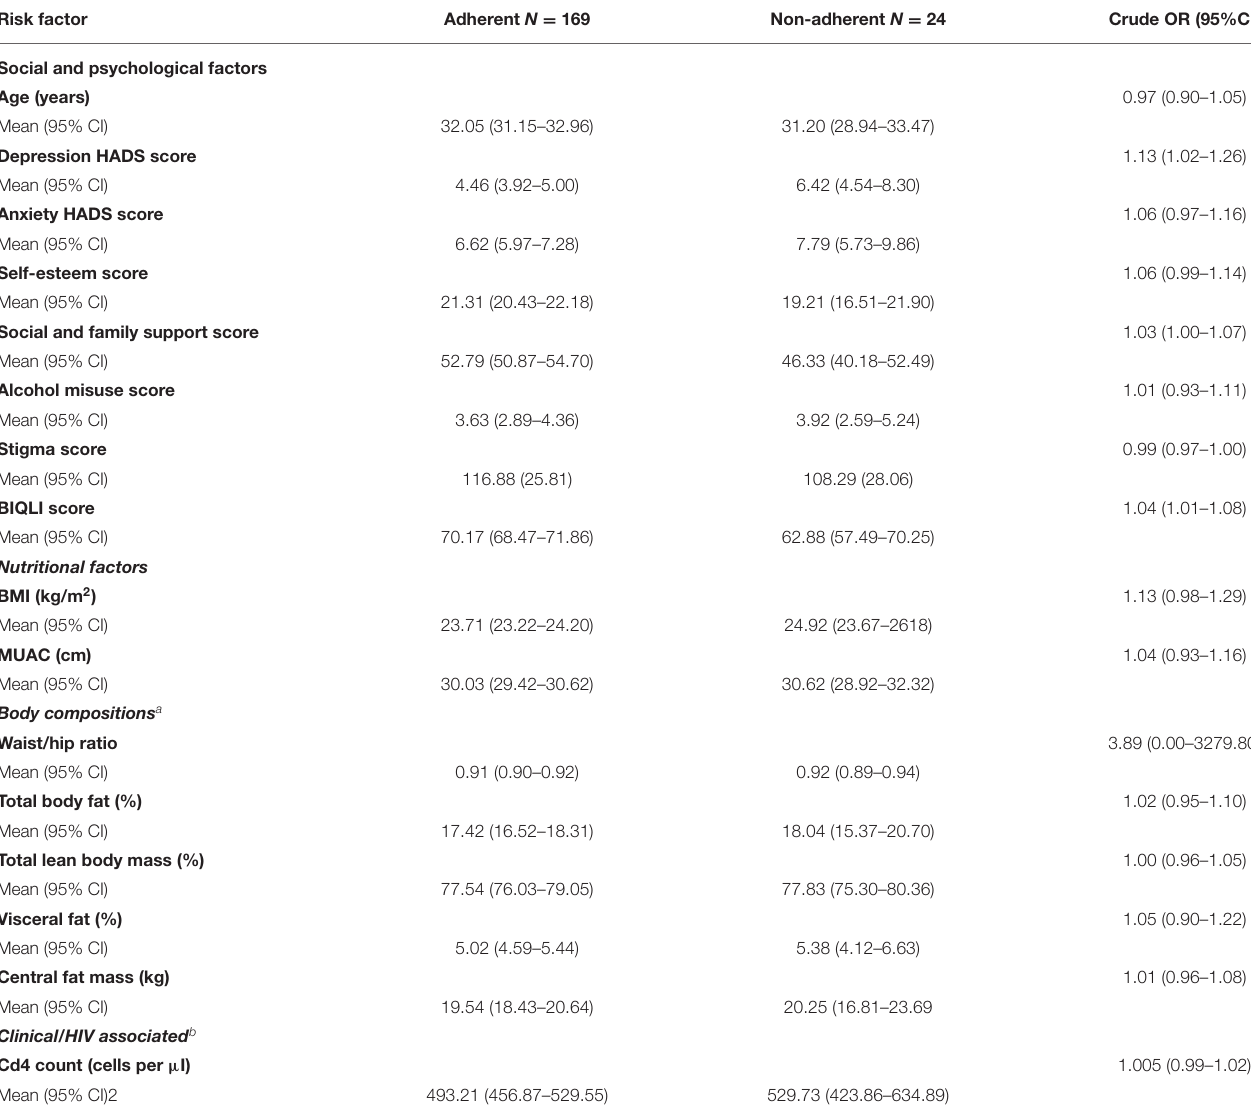
TABLE 3 | Social, psychological, and nutrition factors and ART non-adherence as continuous measure.